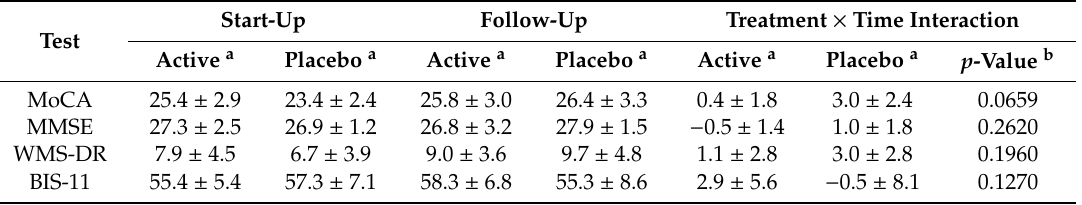
Table 6. Two-way analysis of treatment × time interaction in psychometric tests of active and placebo groups for male